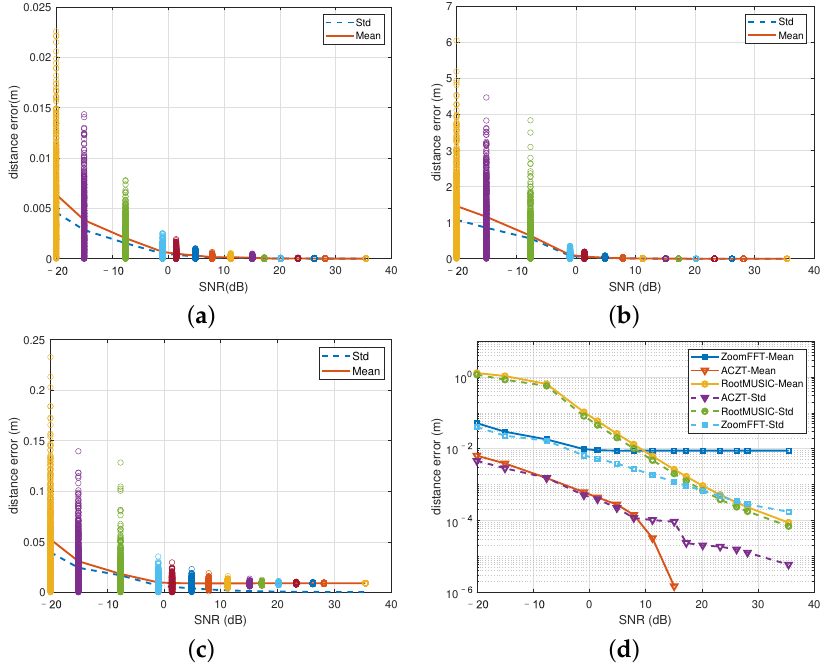
Figure 13. The distance error of three different algorithms. ( a ) is distance error of the ACZT; ( b ) is distance error of the RootMUSIC; ( c ) is distance error of the ZoomFFT; ( d ) is the comparison of distance error for three algorithms.